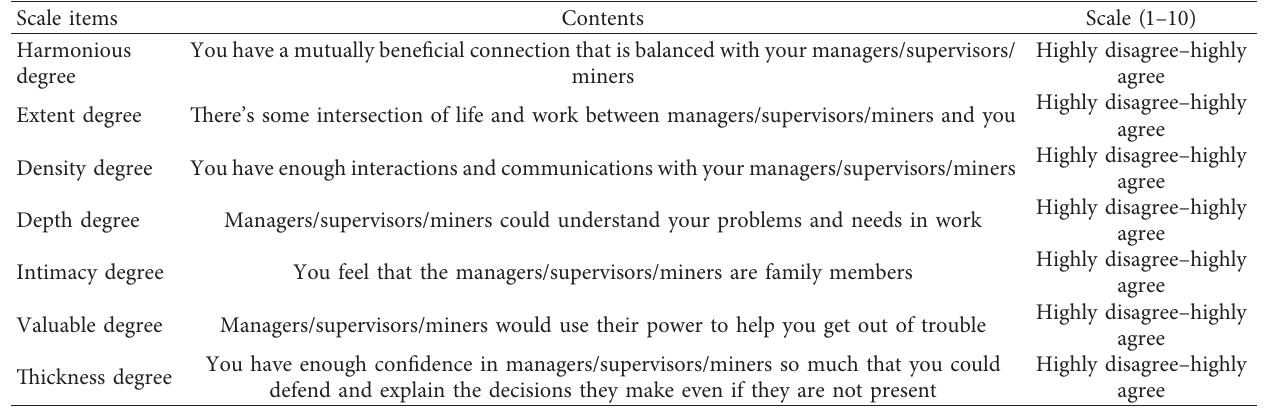
Table 1: Scale of organizational relationship.